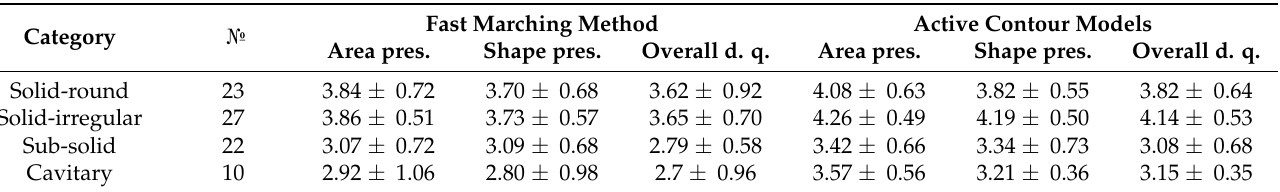
Table 6. Subjective evaluation results as means and standard deviations of the scores for each category, specifying the number of cases